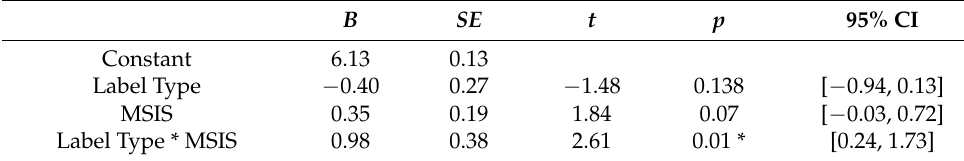
Table 2. Unstandardised regression coefficients for intensity ratings ( N = 170).